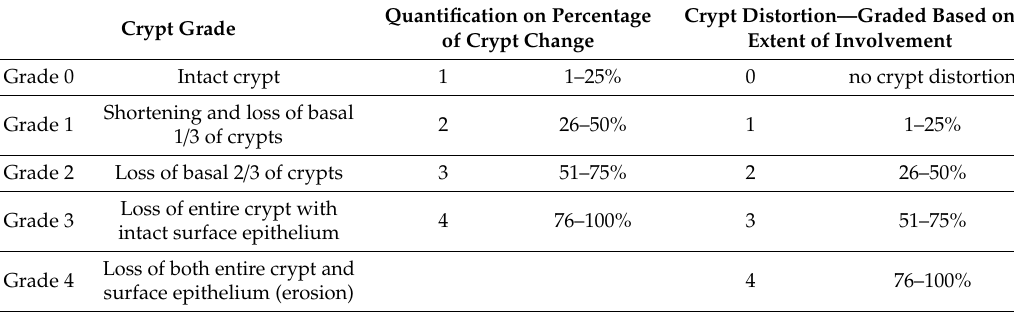
Table 3. Colon tissue histological examination for inflammation